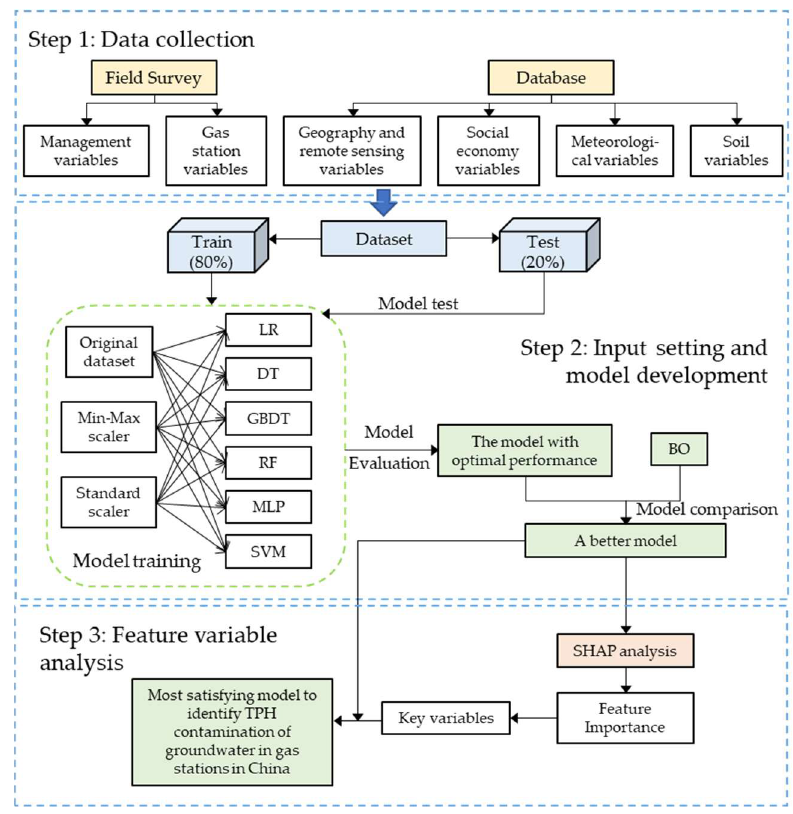
Figure 1. Methodological framework in this study.